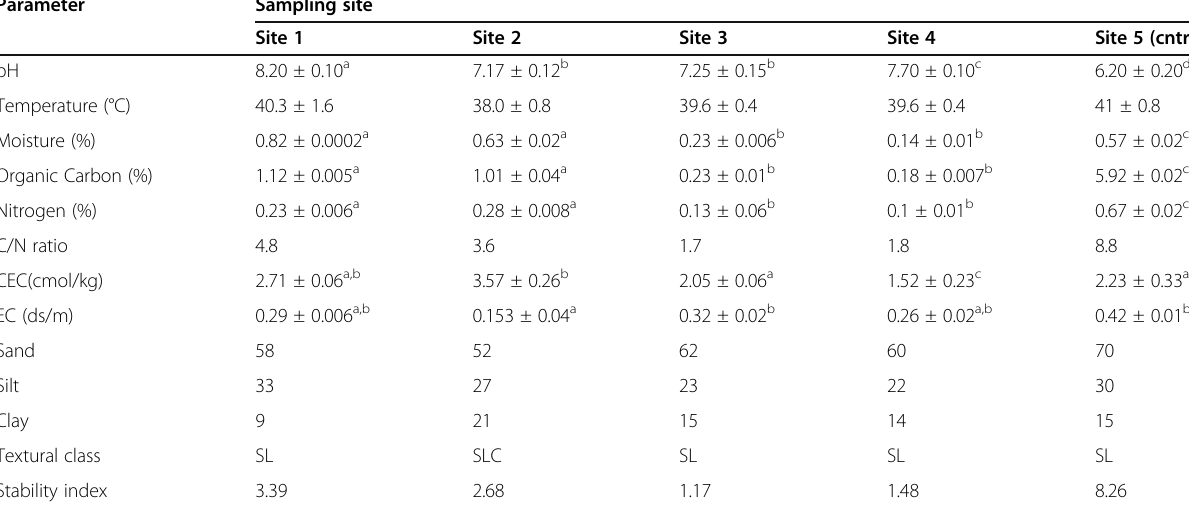
Table 1 Physical and chemical properties of soil obtained from different mining sites of Zamfara State Parameter